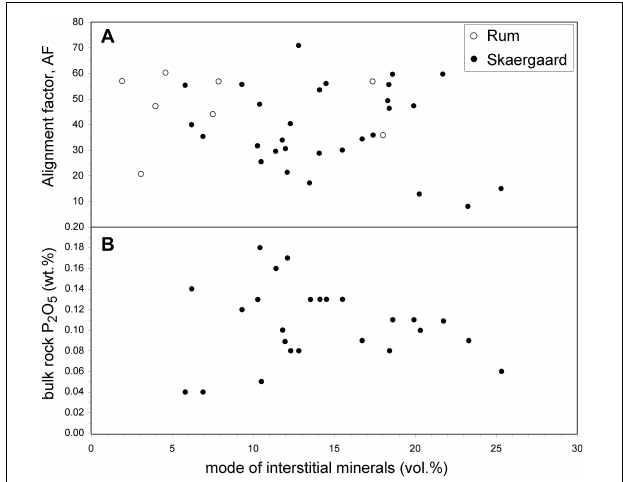
FIGURE 6 | (A) The variation of alignment factor (AF) as a function of the volumetric proportion of interstitial phases (i.e., all phases other than plagioclase and olivine) in the Skaergaard and Rum troctolites. (B) The variation of bulk rock P 2 O 5 [reported by Holness et al. (2015) and shown in Table 1 ] as a function of the volumetric proportion of interstitial phases in the Skaergaard troctolites. shape in natural examples (Meurer and Boudreau, 1998;